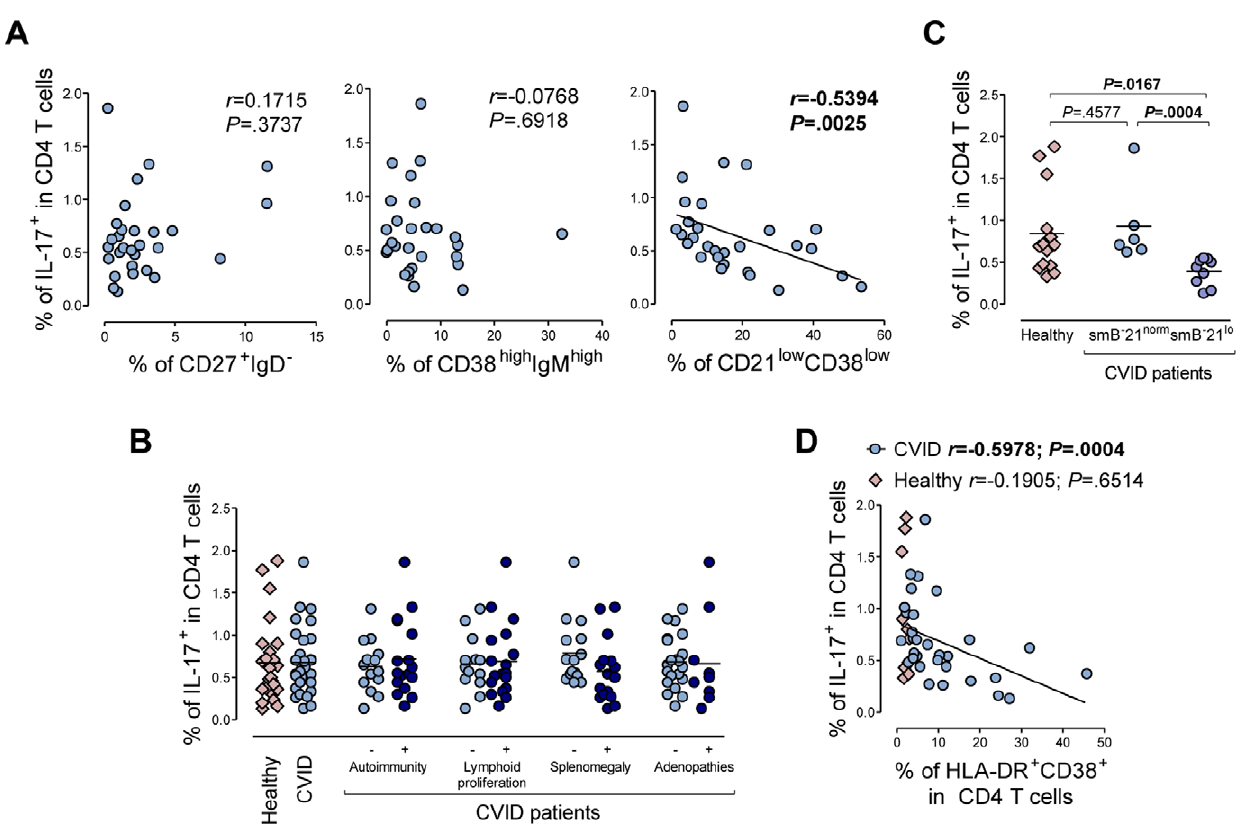
Figure 1. Th17 cells in patients with CVID. (A) Correlation between Th17 frequency and frequency of switched-memory B cells (left), transitional B cells (middle) or CD21 low B cells (right), in CVID patients. Switched-memory B cells were defined as CD27 + IgD 2 cells, transitional B cells as CD38 high IgM high cells and CD21 low B cells were defined as CD21 low CD38 low cells within gated B cells (CD19 + ) after surface staining of whole blood samples. IL- 17 expression was assessed at the single-cell level by intracellular staining following short-term stimulation of PBMC with PMA and ionomycin. (B) Th17 frequency in CVID individuals stratified according to their clinical manifestations, namely autoimmunity, lymphoid proliferation, splenomegaly, and adenopathies. (C) Th17 frequency in healthy controls and CVID patients grouped according to EUROclass. (D) Correlations between frequencies of activated CD4 T cells, defined by concurrent expression of HLA-DR and CD38, and of Th17 cells in CVID and healthy individuals. Each symbol represents one individual. Bars represent mean. Data were compared using Mann-Whitney test, and P values are shown. Correlation significance was assessed using Spearman coefficient test, and r and P values are shown.